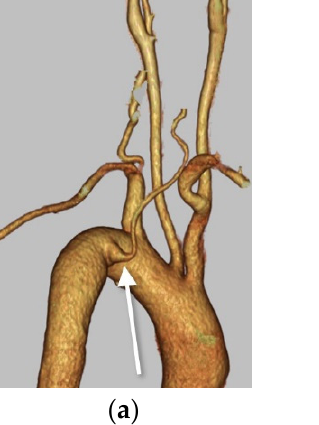
Figure 4. Right VA originating from the aortic arch with a diverticulum of Kommerell. ( a ) Right posterior oblique view on VR-CT angiography shows the RVA directly arising from the aortic arch (long white arrow) distal to the left subclavian artery with a diverticulum of Kommerell. ( b ) Axial contrast-enhanced CT shows the right vertebral artery (white long arrow) arising from the aortic arch as the fourth branch with a diverticulum of Kommerell (*). The Ziostation 2 (Ziosoft Inc., Tokyo, Japan) was used to obtain the VR